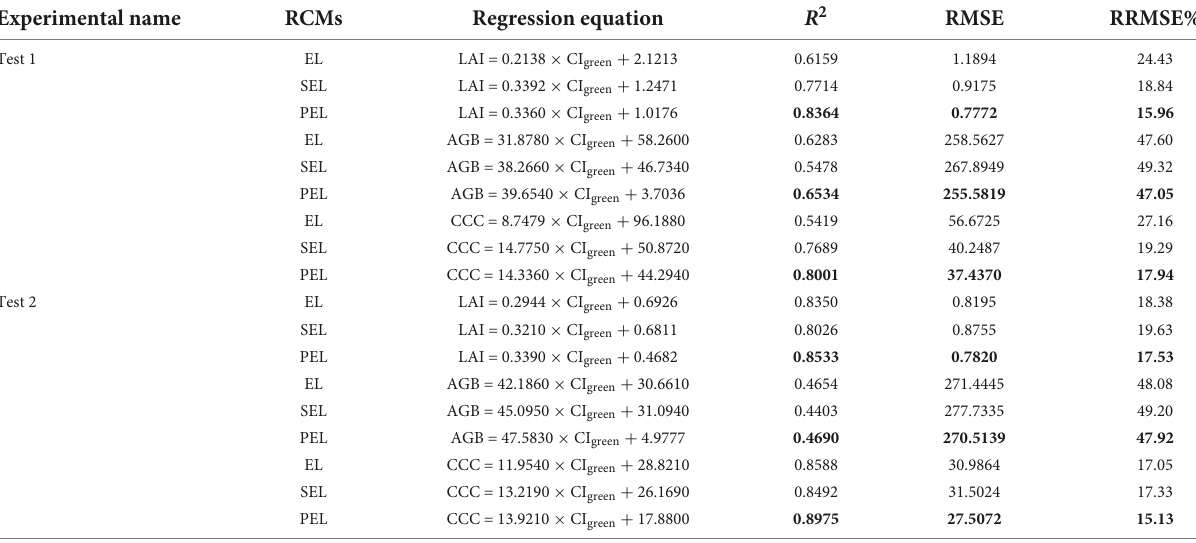
TABLE 5 The linear regression models for monitoring rice growth parameters based on three RCMs in Test 1 and Test 2.